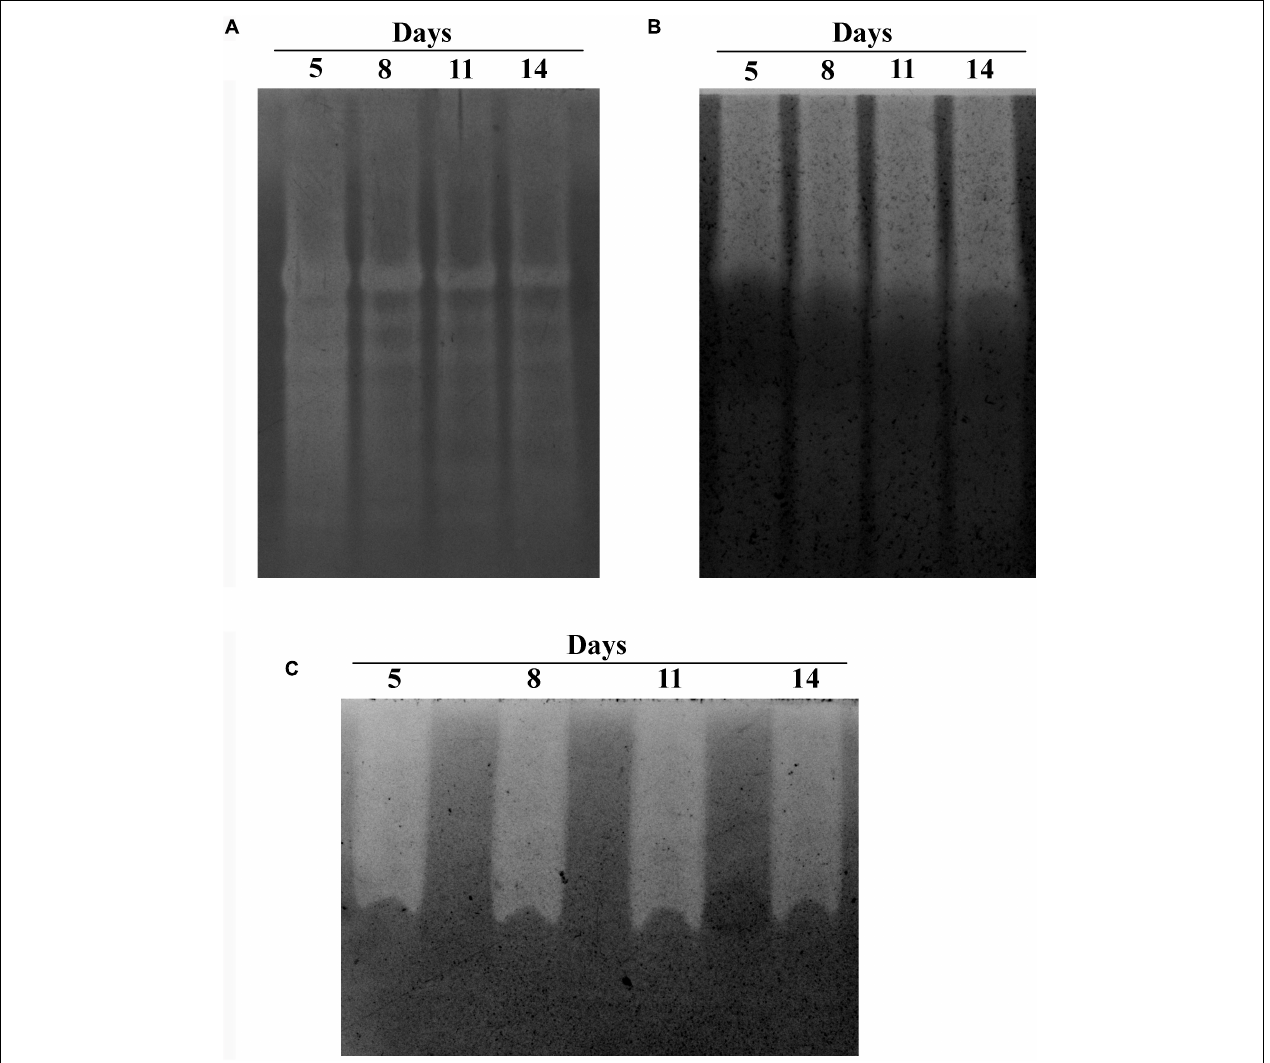
FIGURE 5 | Zymogram analysis of secretory xylanase, endoglucanase, and amylase enzymes. Secretome of M. phaseolina was collected 5, 8, 11, and 14 days after inoculation in solid-state culture, and zymogram was studied for xylanase, endoglucanase, and amylase. (A) Zymogram analysis of xylanase. The resolving gel was casted with 0.1% birchwood xylan. The gel was stained with 0.1% Congo red and destained with 1 M NaCl solution. The decolorized region in the gel picture indicated the presence of xylanase. (B) Zymogram analysis of endoglucanase. The resolving gel was casted with 0.1% CM cellulose. The gel was stained with 0.1% Congo red and destained with 1 M NaCl solution. The decolorized region in the gel picture indicated the presence of endoglucanase. (C) Zymogram analysis of amylase. The resolving gel was casted in with 0.1% starch. The gel is stained with iodine solution. The decolorized region in the gel picture indicated the presence of